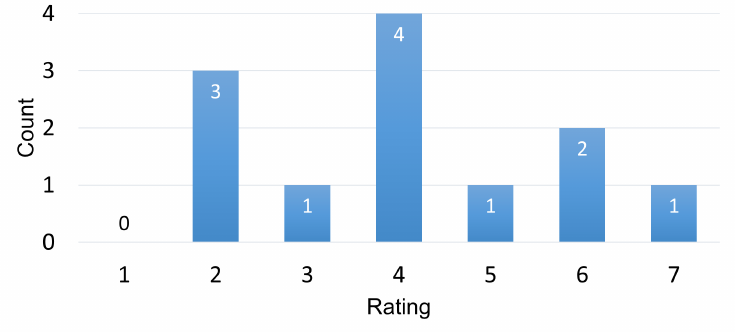
Figure 16. Answers for agreement to the statement related to H4 “The more I had to think during a question, the more helpful the pausing was for me”. 1 = fully disagree, 7 = fully agree; n =